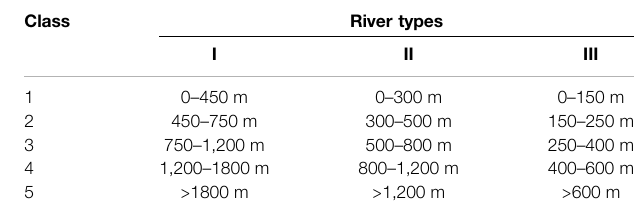
TABLE 4 | Classi fi cation of rivers.